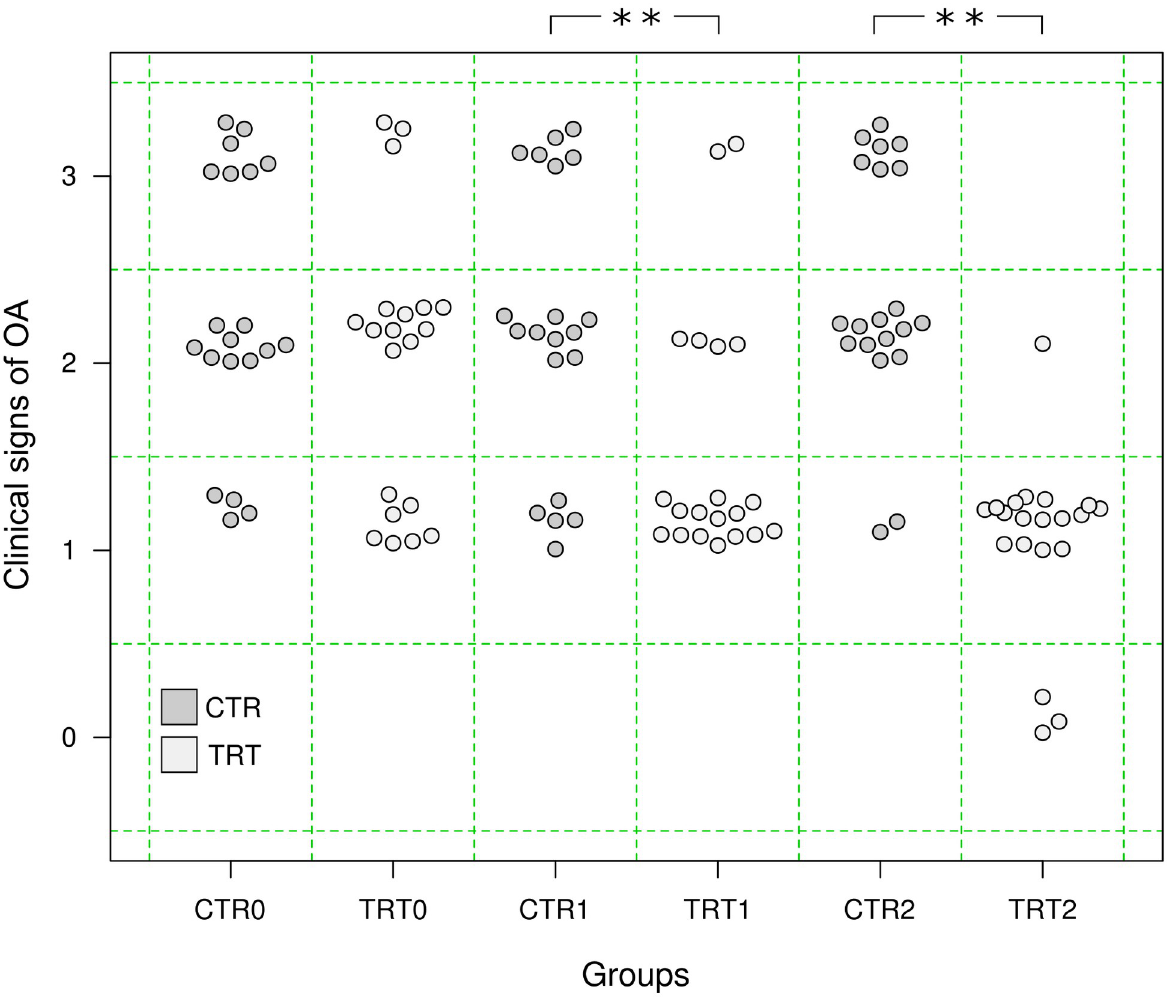
Fig 1. Comparison of clinical signs of OA between CRT and TRT groups at three time points (T0, T1, T2), �� p < 0.01, Mann-Whitney U test.